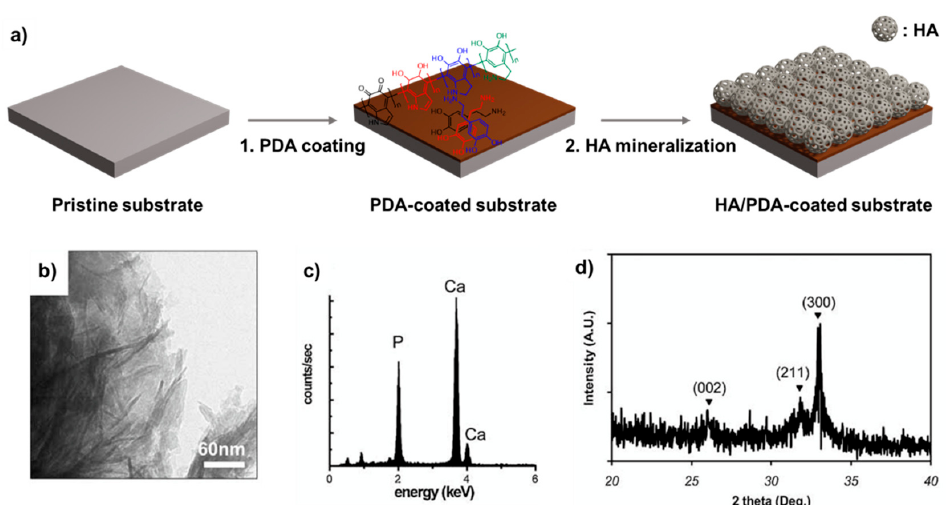
Figure 3. ( a ) Schematic illustration of polydopamine-assisted hydroxyapatite functionalization (pHAF) coating of the PDA layer by auto-oxidation of the DA on the substrate, followed by the mineralization of HA on PDA layer in SBF solution. Characterization of HA formed on the PDA-coated Titanium substrate: ( b ) TEM, ( c ) EDX, ( d ) XRD. Reprinted with permission from reference [2]. Copyright Wiley 2010.